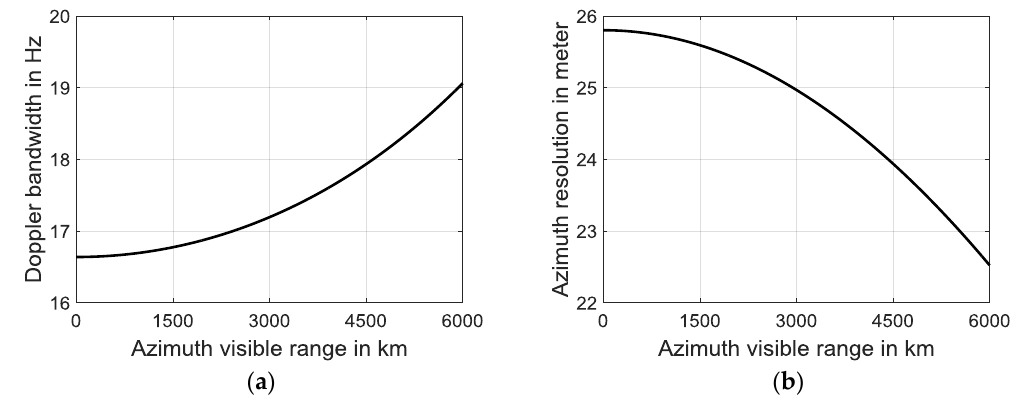
Figure 4. Doppler bandwidth ( a ) and Azimuthal resolution ( b ) as a function of azimuth visible range.